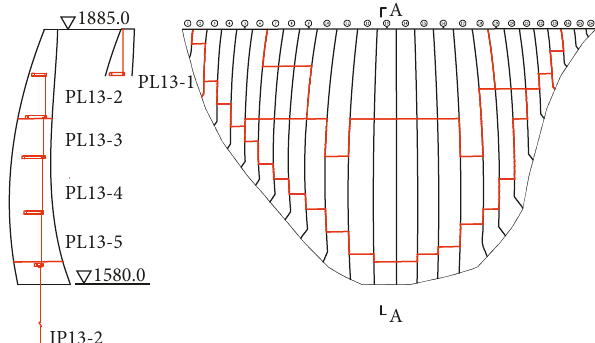
Figure 1: Layout of concrete zoning and pendulum of an arch